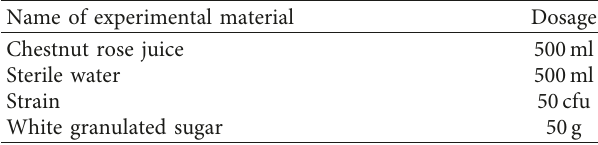
Table 2: Single-factor experimental formulation